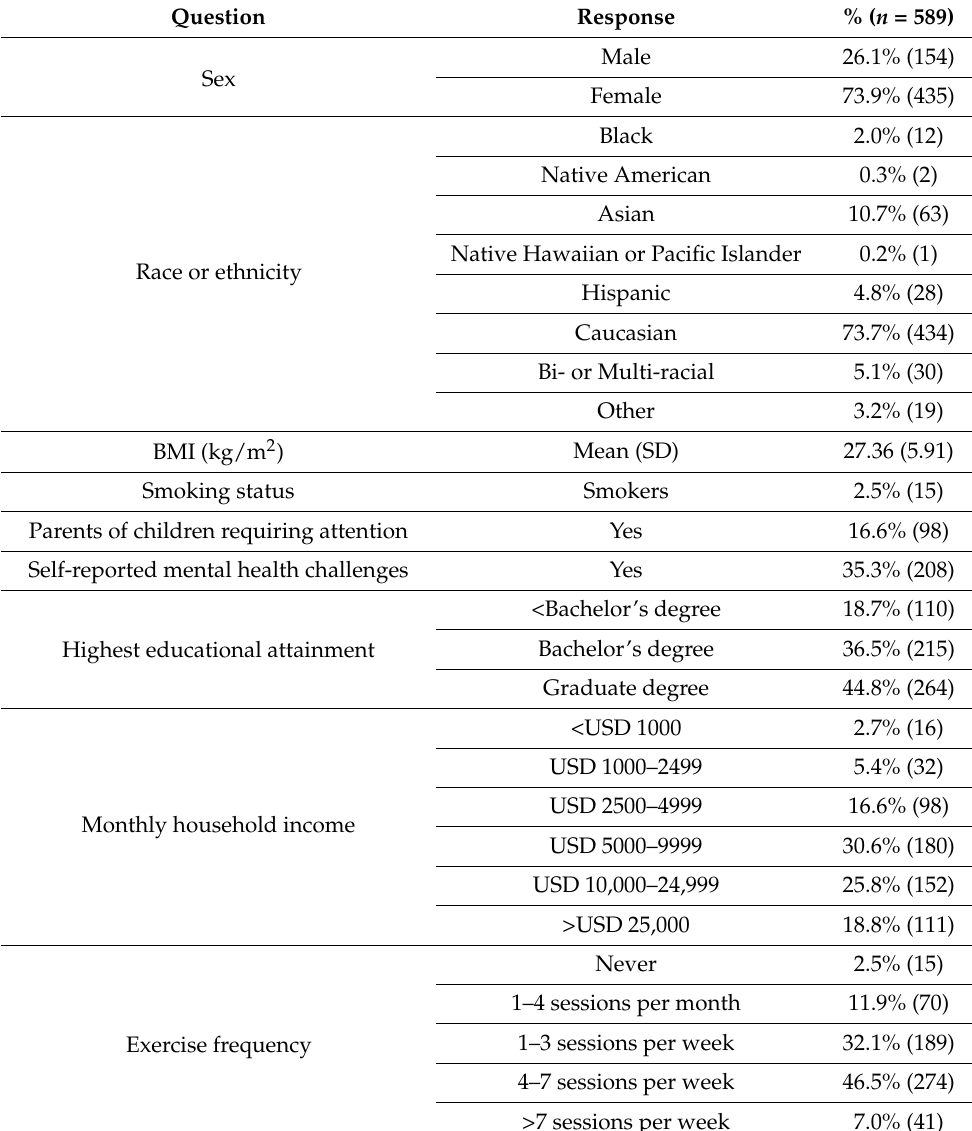
Table 1. Participant